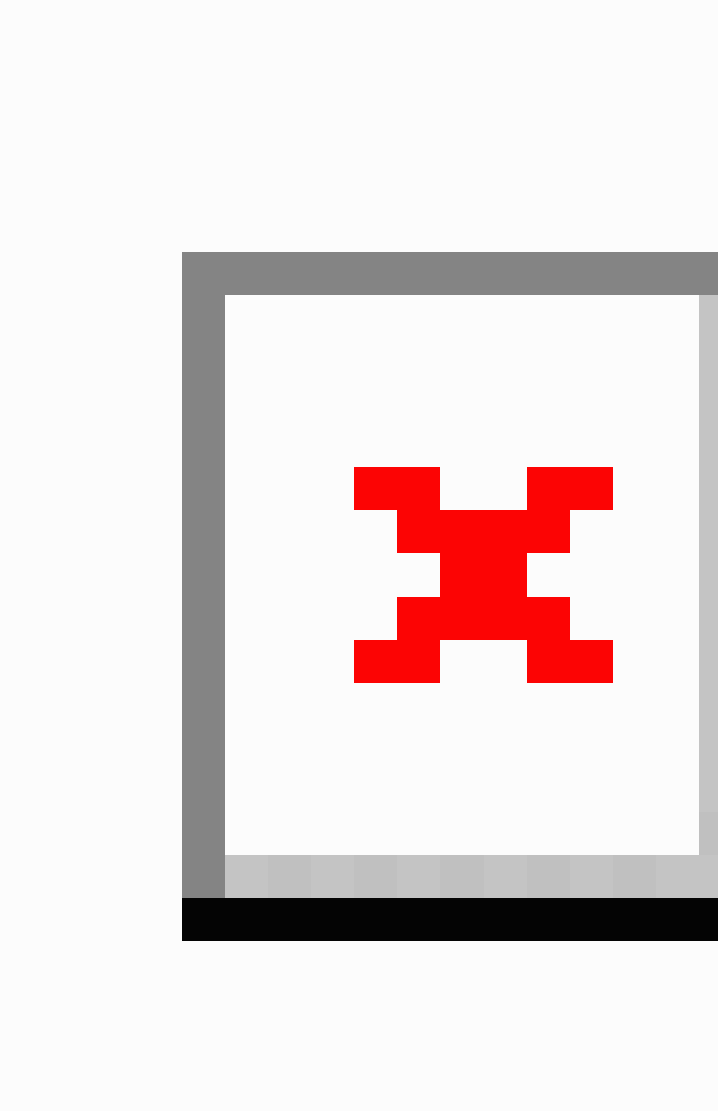
Figure 5. Flowchart of the recruitment process of study